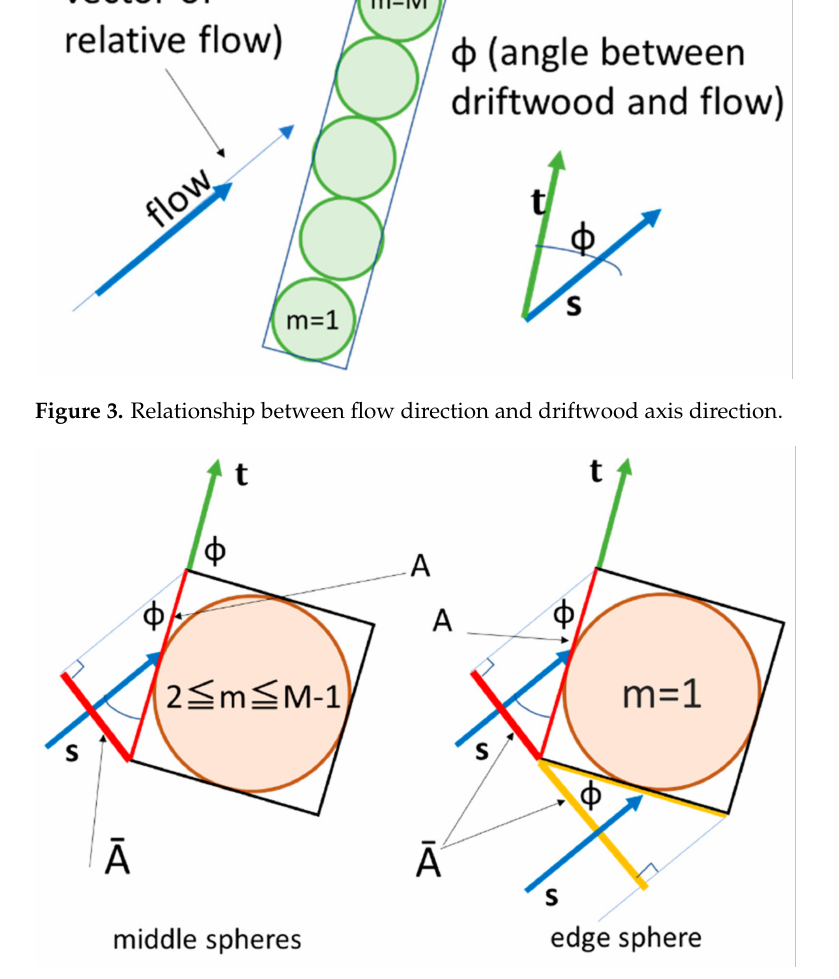
Figure 4. Modified projection area ¯A considering the angle between flow direction and driftwood axis direction (= φ